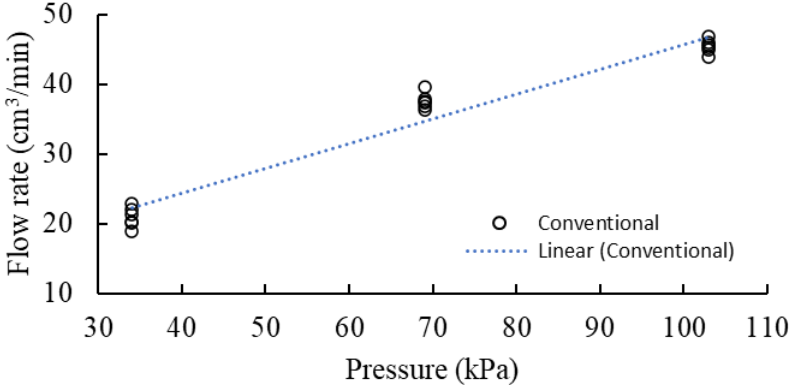
Figure 2. Relationship between water flow and pressure with conventional drip irrigation.